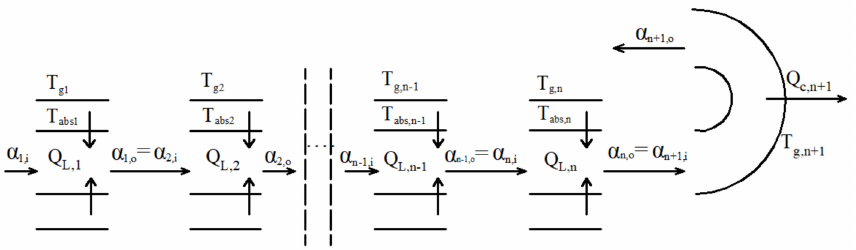
Figure 13. Two-phase flow, gas mass fraction of the tube